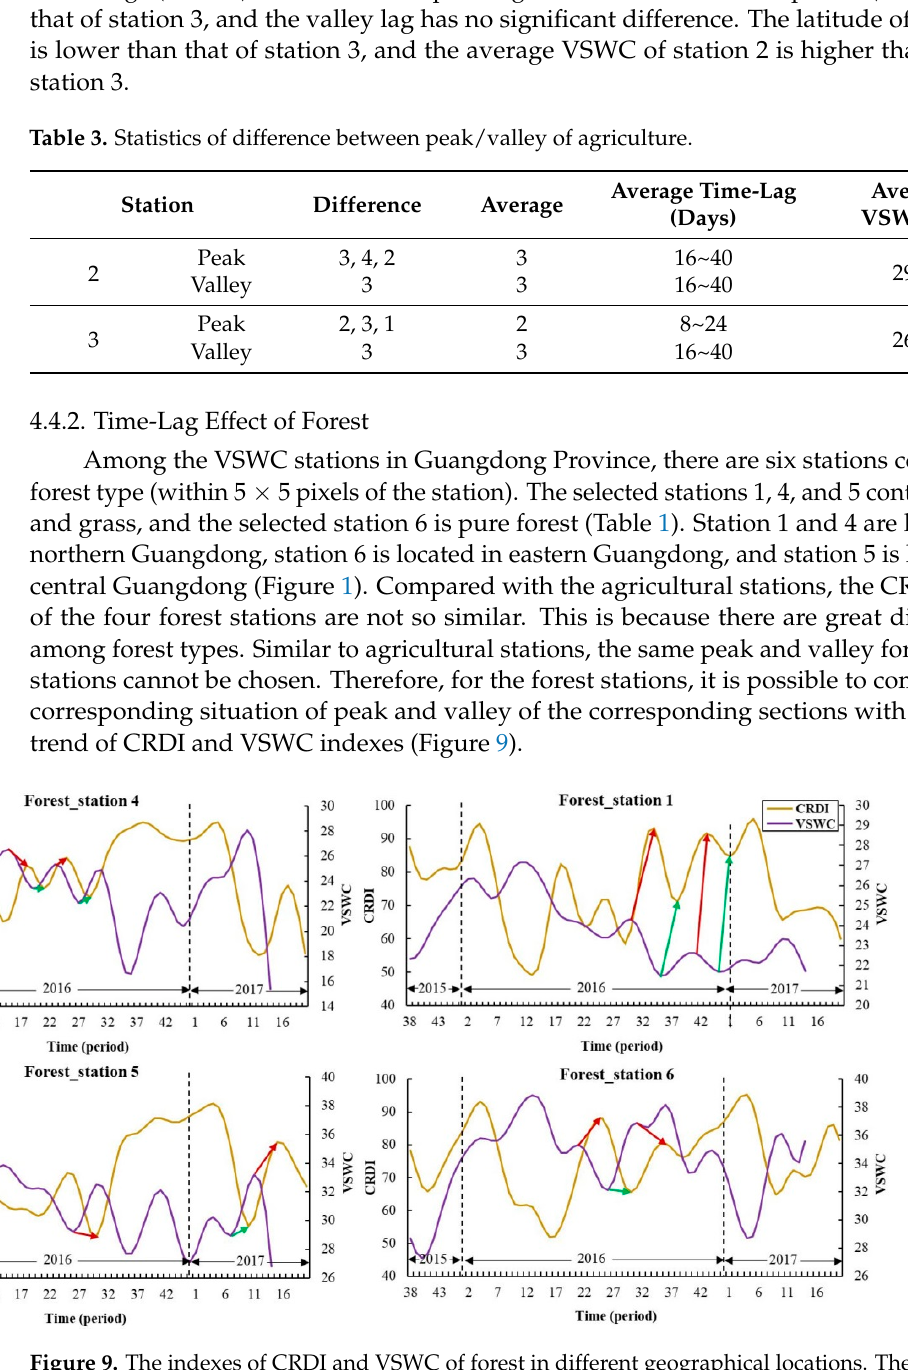
Figure 9. The indexes of CRDI and VSWC of forest in different geographical locations. The red arrow represents the lag of the peak, and the green arrow represents the lag of the valley. The dotted line represents the division of